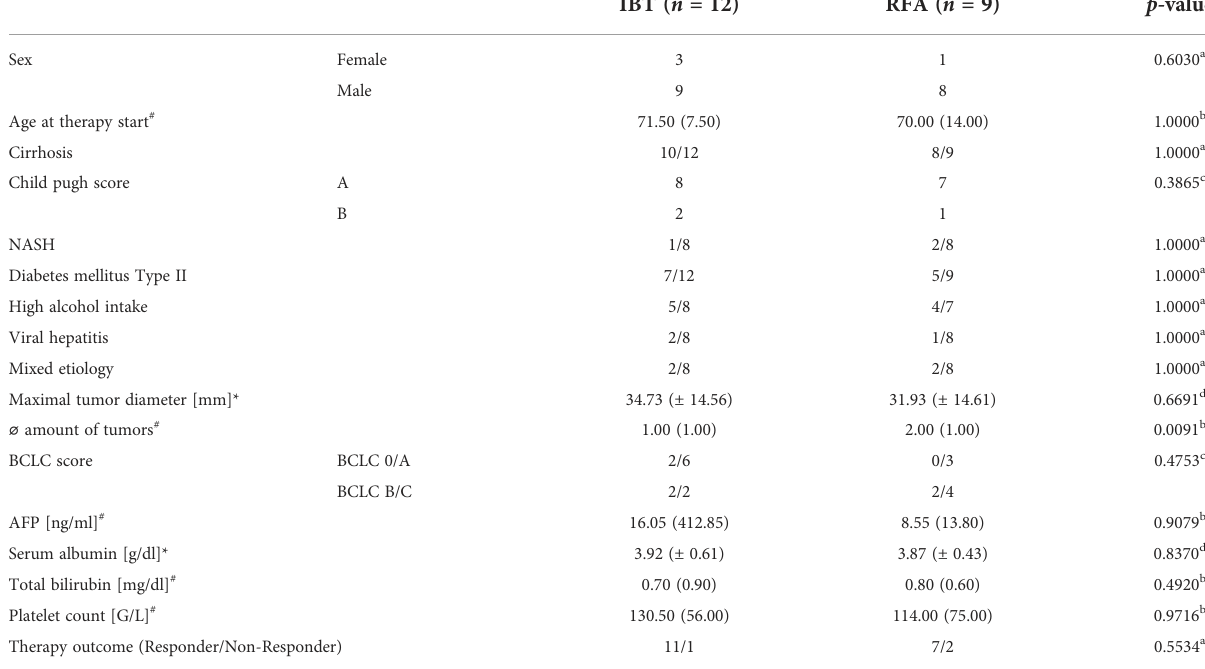
TABLE 1 Clinical characteristics of the study